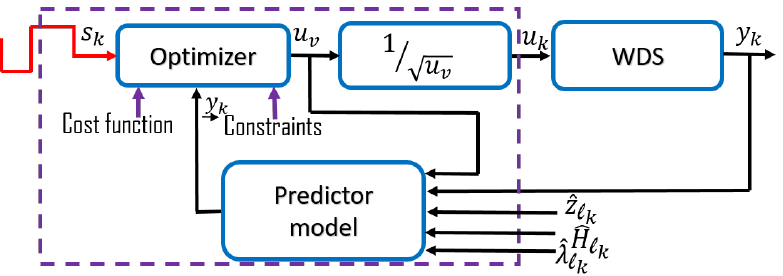
Figure 6. MPC scheme for pressure